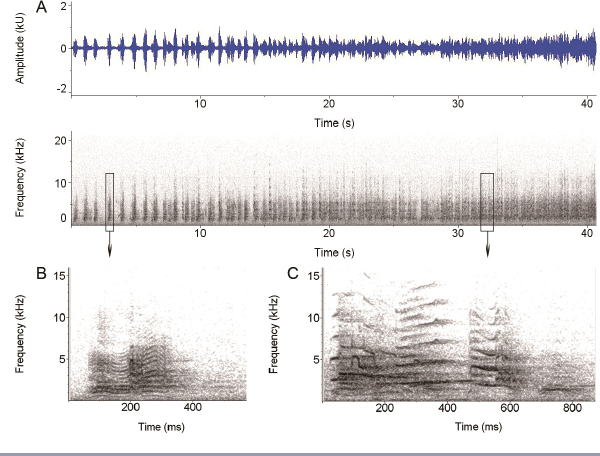
Fig. 2 . (A) Spectrograms of the territorial chorus of the Buff- throated Partridges used in the study (settings: Hann type, window size = 512 samples, Discrete Fourier Transformation length = 1024 samples, and overlap = 97.1%, with a time resolution of 0.34 ms and a frequency resolution of 43.1 Hz, respectively); (B) An typical syllable of prelude phase; (C) An typical syllable of loud song phase. Spectrograms were made with Raven Pro 1.4 (Charif et al.